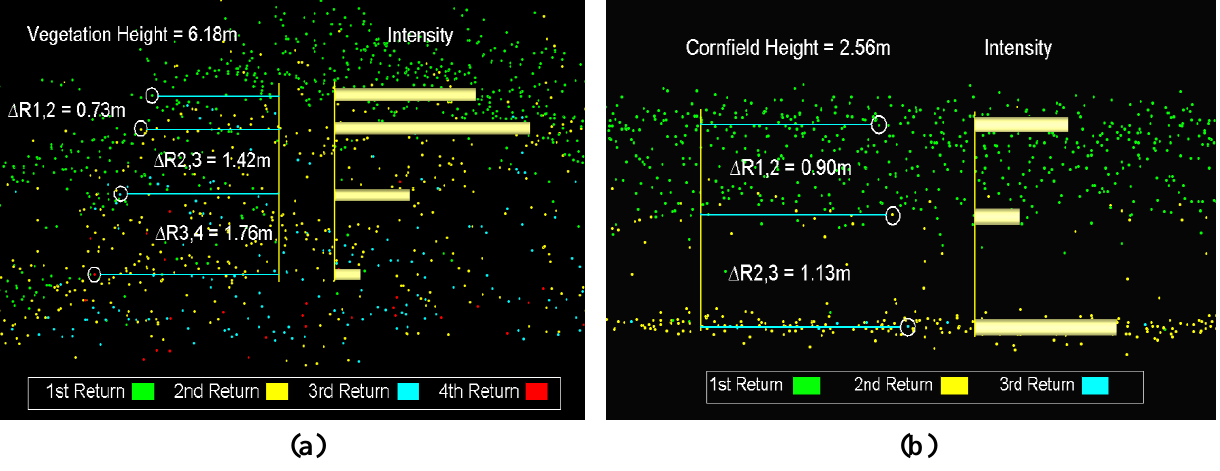
Figure 2. ALTM-Orion data: ( a ) A four-return record for one emitted laser pulse over 6 m high mixed forest; ( b ) A three-return record for one emitted laser pulse over 2.6 m high